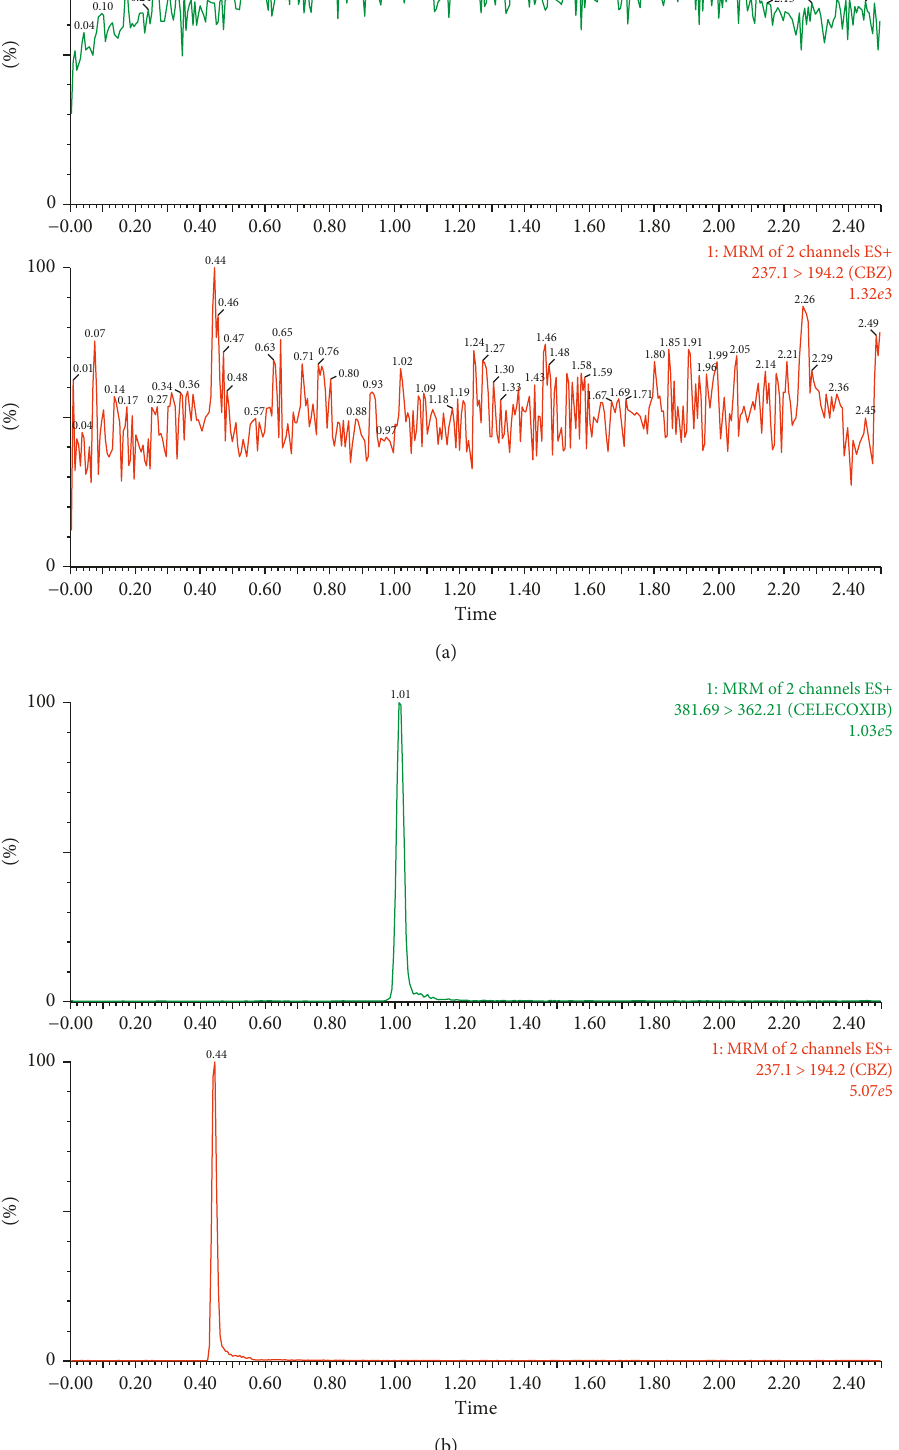
Figure 2: UPLC-MS/MS chromatograph of celecoxib and IS. (a) Blank plasma sample. (b) Genistein-treated rat plasma sample at 10h after